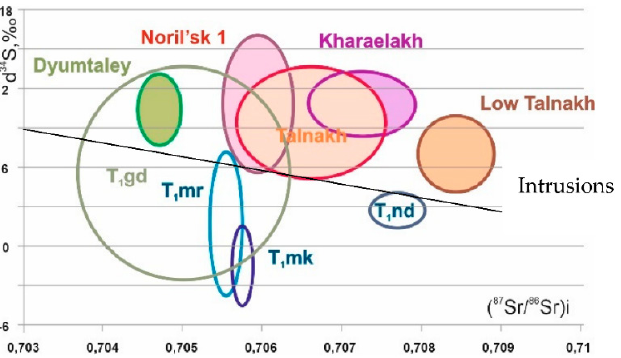
Figure 23. Diagram ( 87 Sr/ 86 Sr) i vs. δ 34 S for intrusions and basalts in the Norilsk area. Data from [52–56].